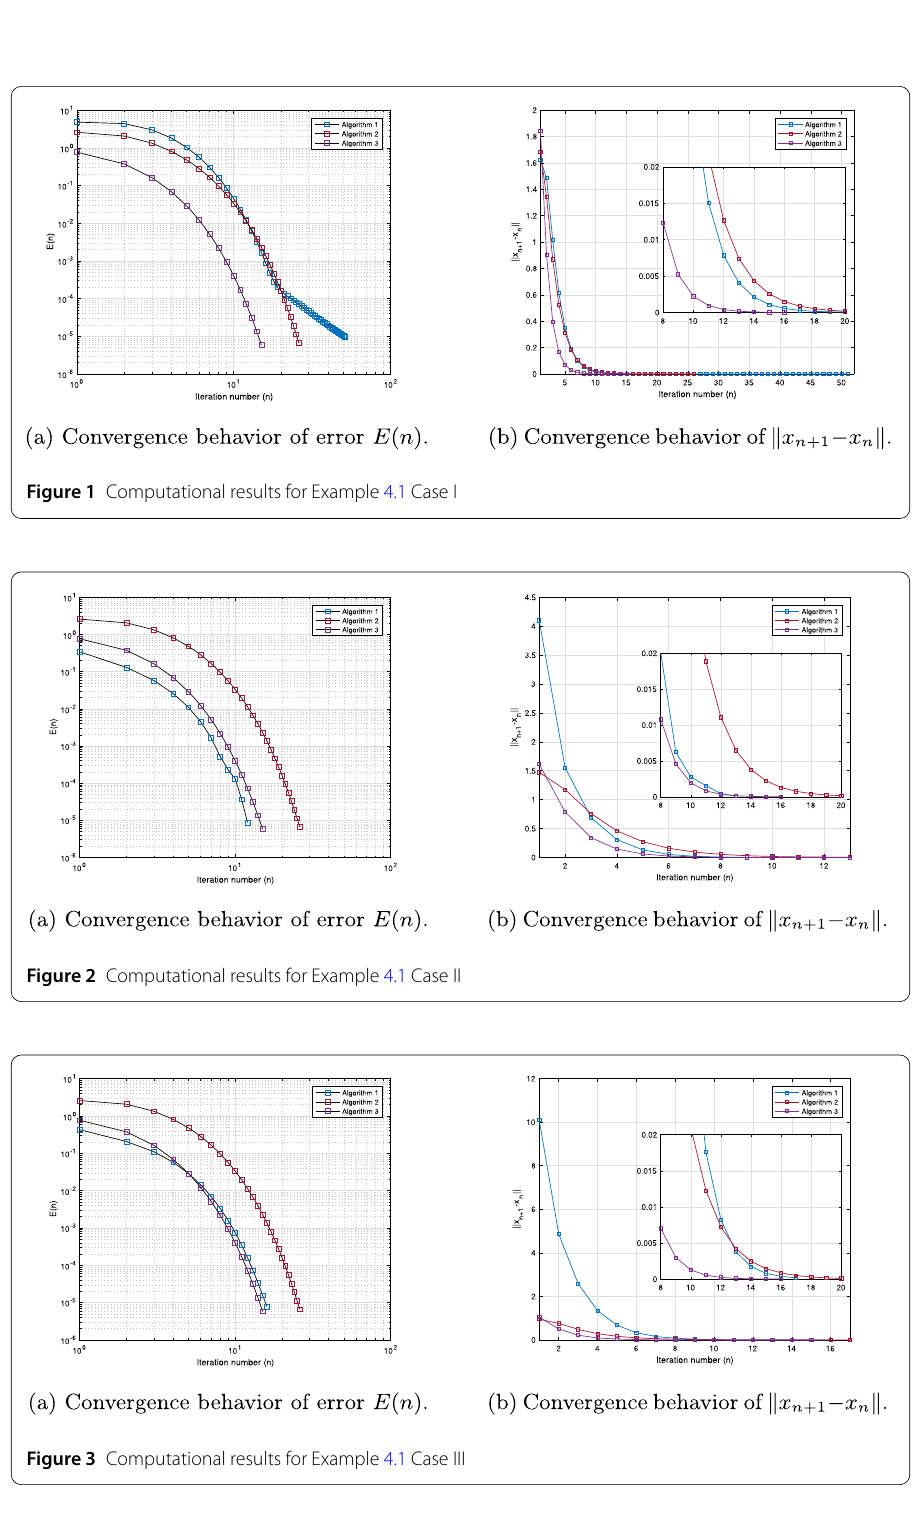
(b) in case II ( ρ n = 2.00 ), the first algorithm was more efficient than other proposed algorithms regarding the number of